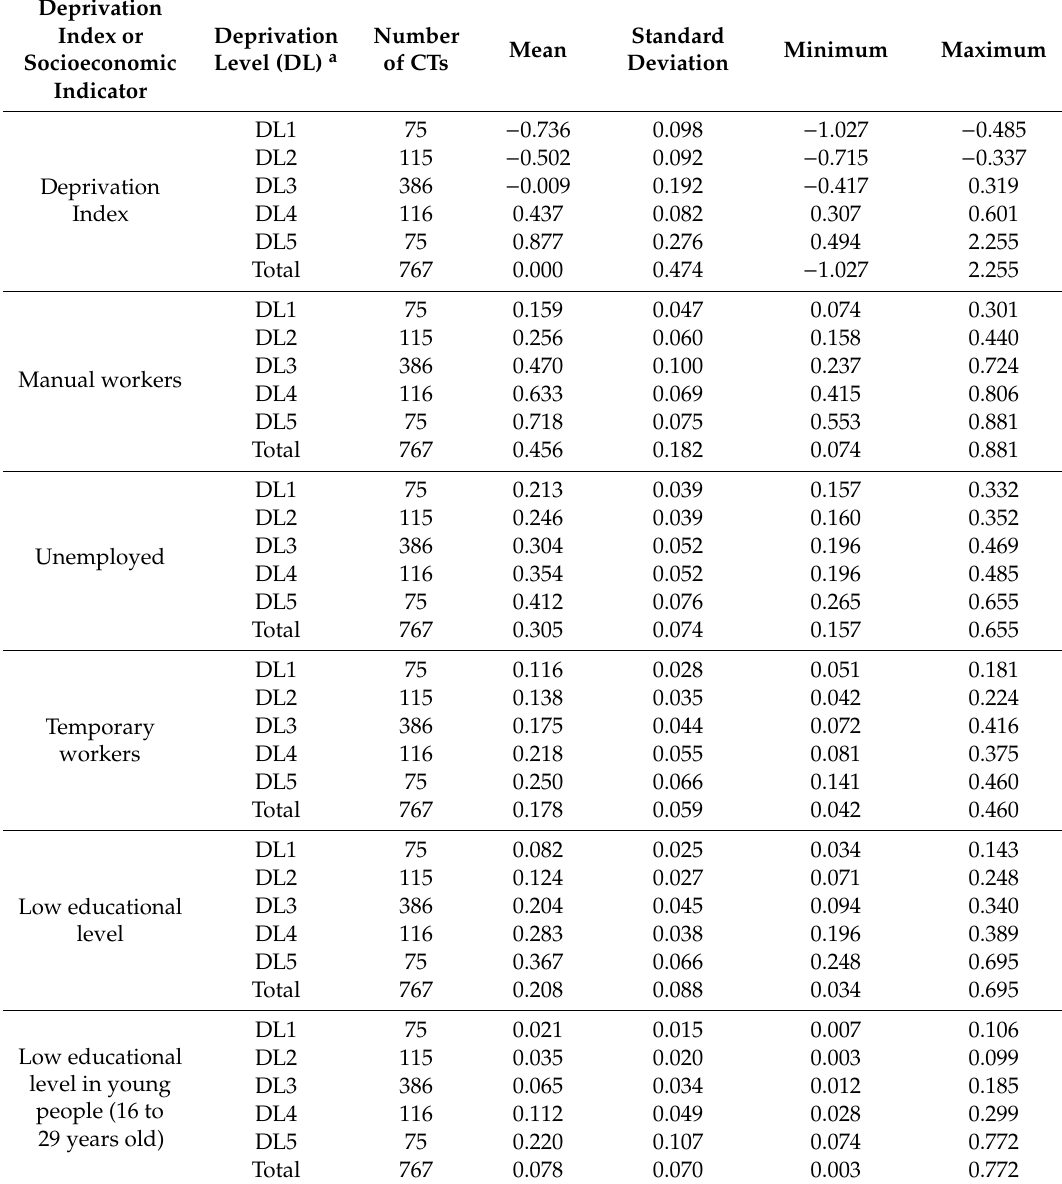
Table 2. Descriptive characteristics of the Deprivation Index and socioeconomic indicators according to deprivation